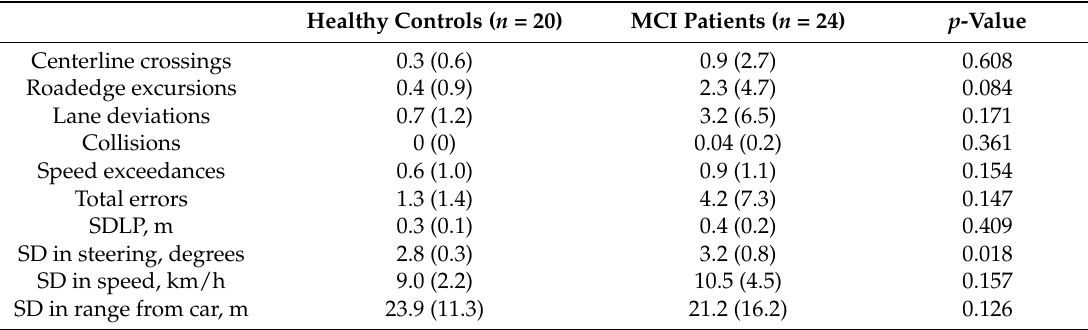
Table 2. Car following simulation outcomes for patients with MCI ( n = 24) and healthy older control participants ( n = 20) for the behavioral session.